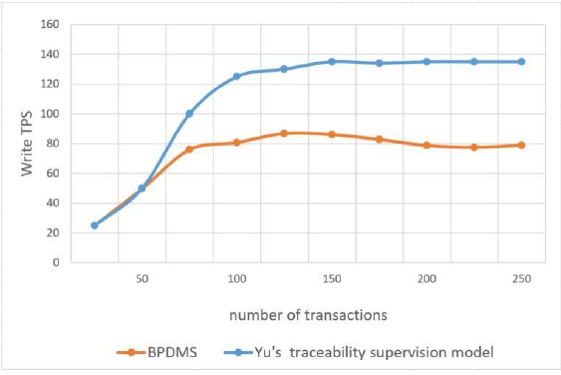
Figure 11. The throughput rate of write data.